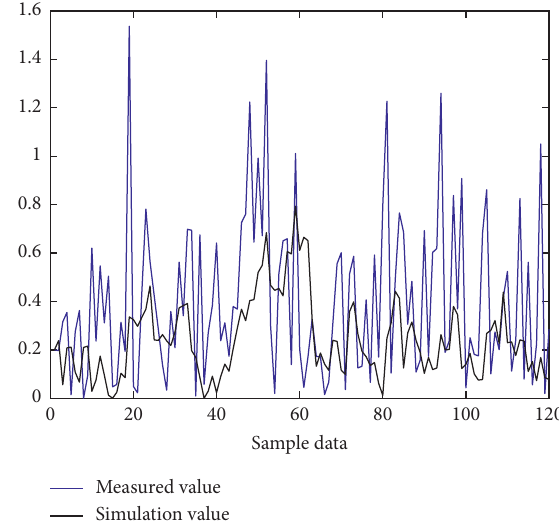
Figure 6: Comparison of predictions of the public opinion before and after